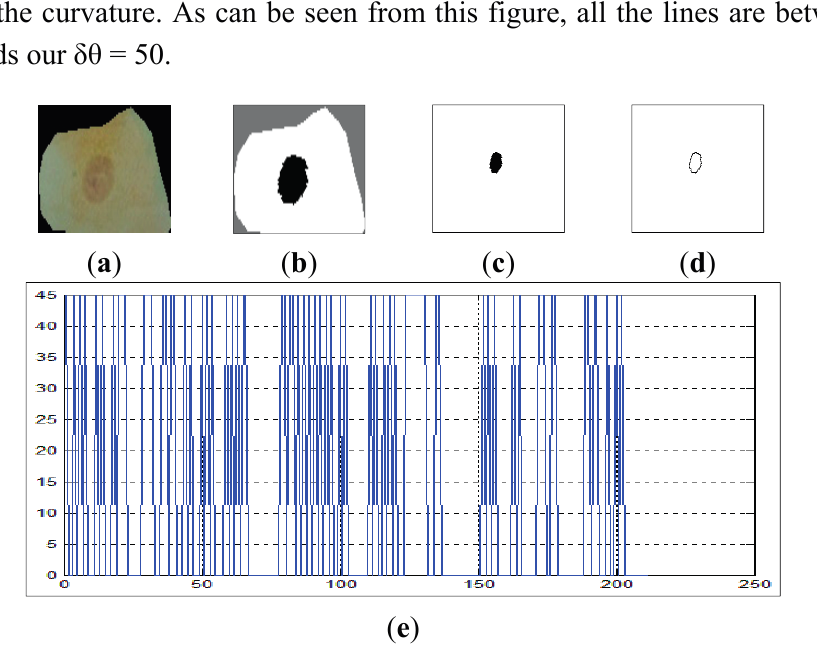
Figure 7. The curvature extraction of a benign cell. ( a ) Sputum cell; ( b ) Nucleus and cytoplasm segmentation; ( c ) Nucleus extraction; ( d ) Nucleus boundary and ( e ) reflects the curvature plot for the image boundary in ( d